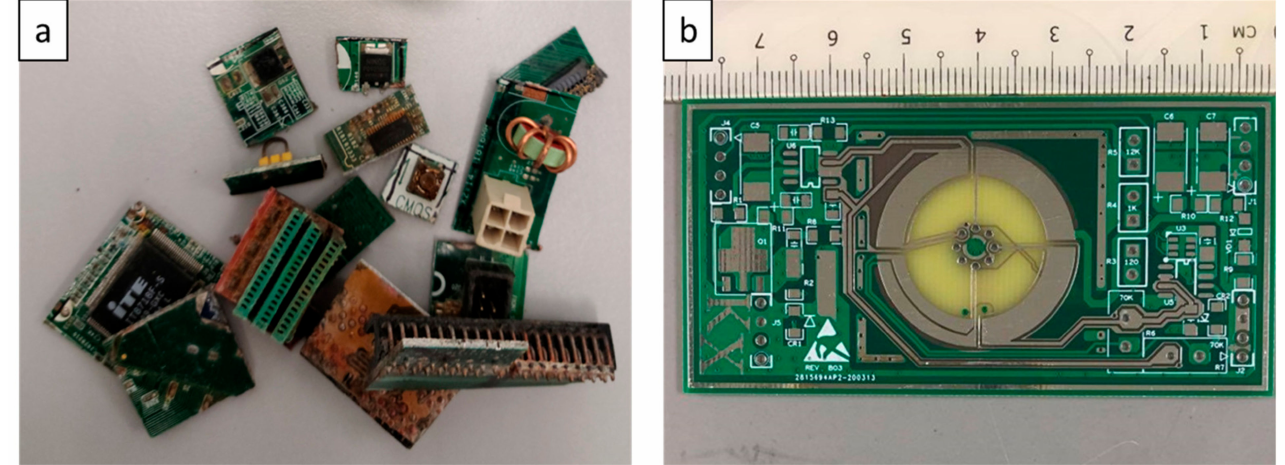
Figure 1. ( a ) Populated PCBs ( b ) unpopulated